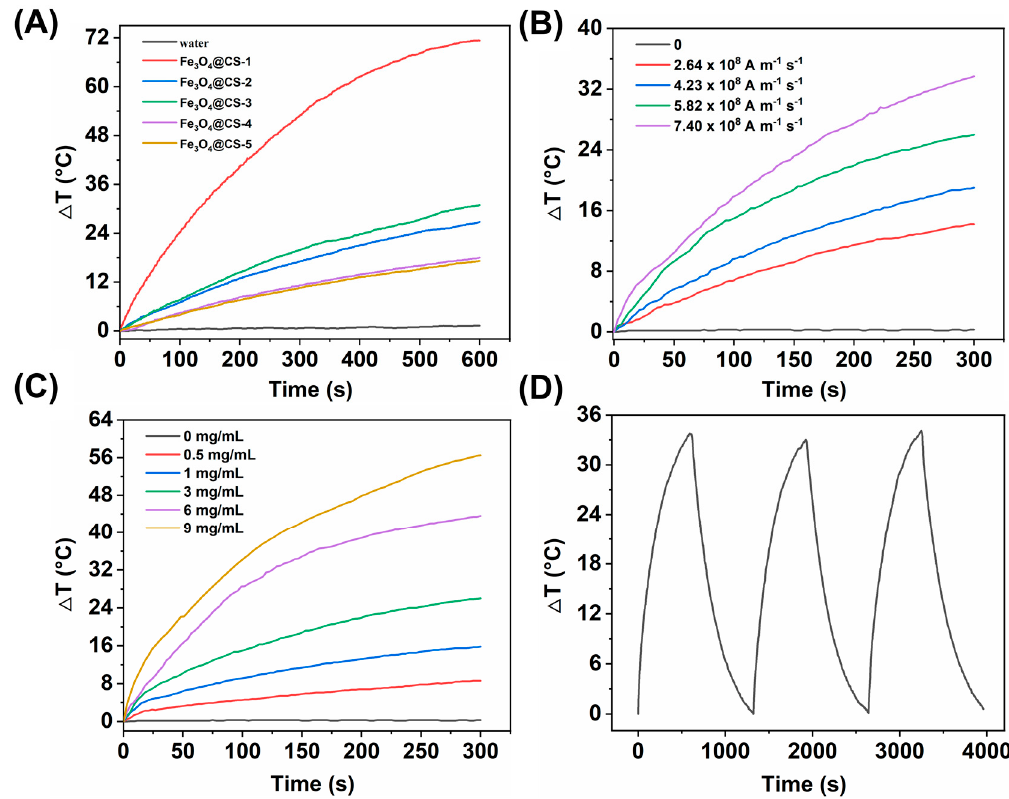
Figure 3. Magneto-thermal curves of Fe 3 O 4 @CS nanoparticles with ( A ) different feeding ratios of chitosan, ( B ) different intensities of AMF, and ( C ) different concentrations of Fe 3 O 4 @CS. ( D ) Magneto-thermal cycle stability of Fe 3 O 4 @CS.